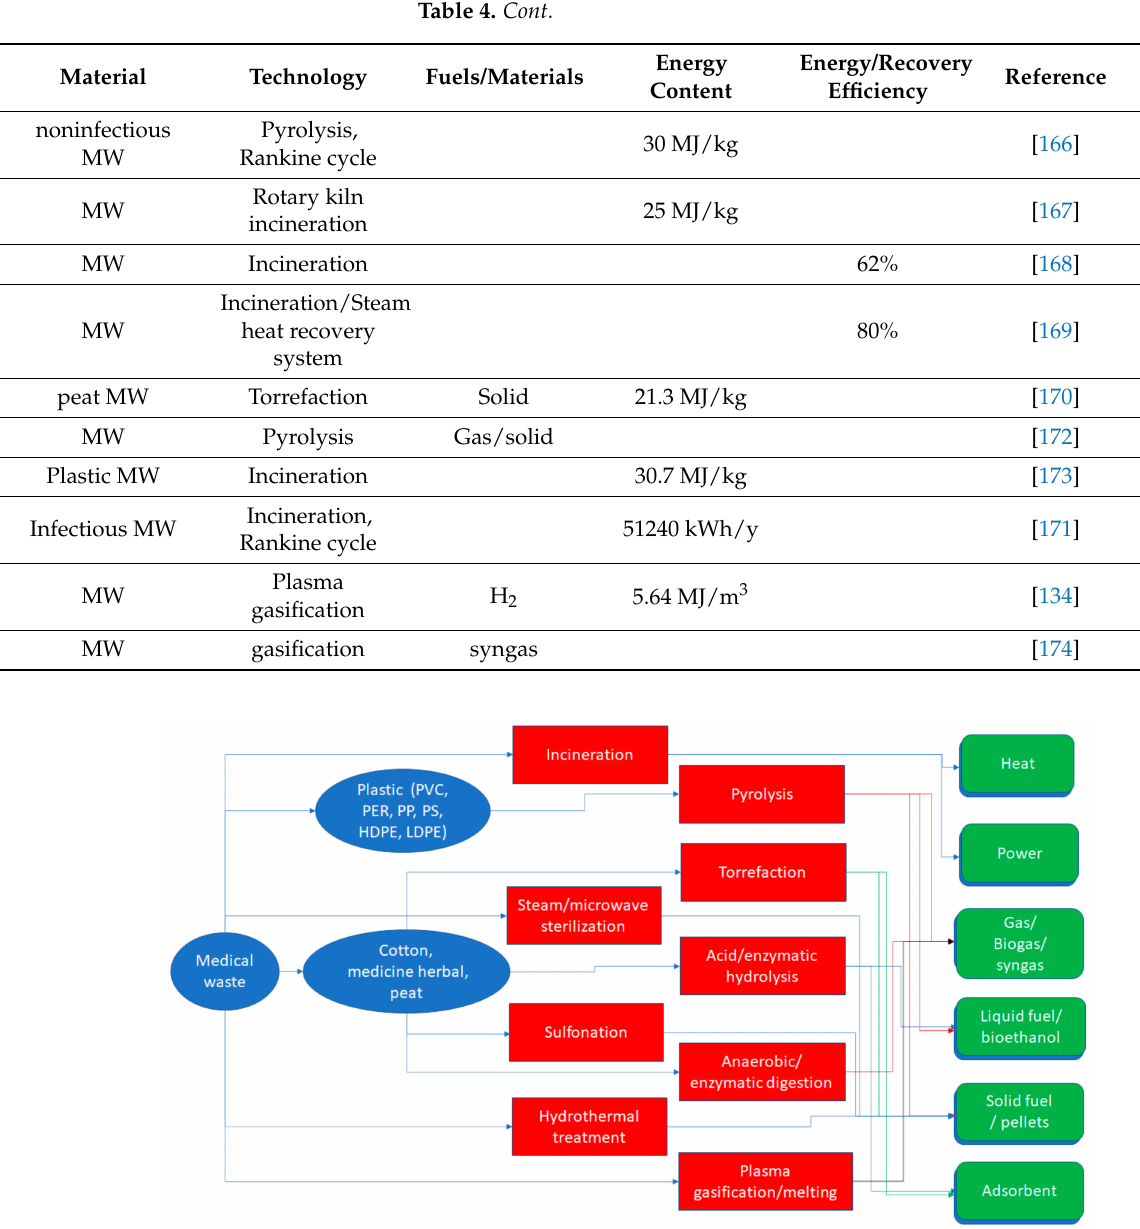
Figure 3. A schematic diagram on energy/fuels/materials production from medical waste and medical waste fractions via various treatment